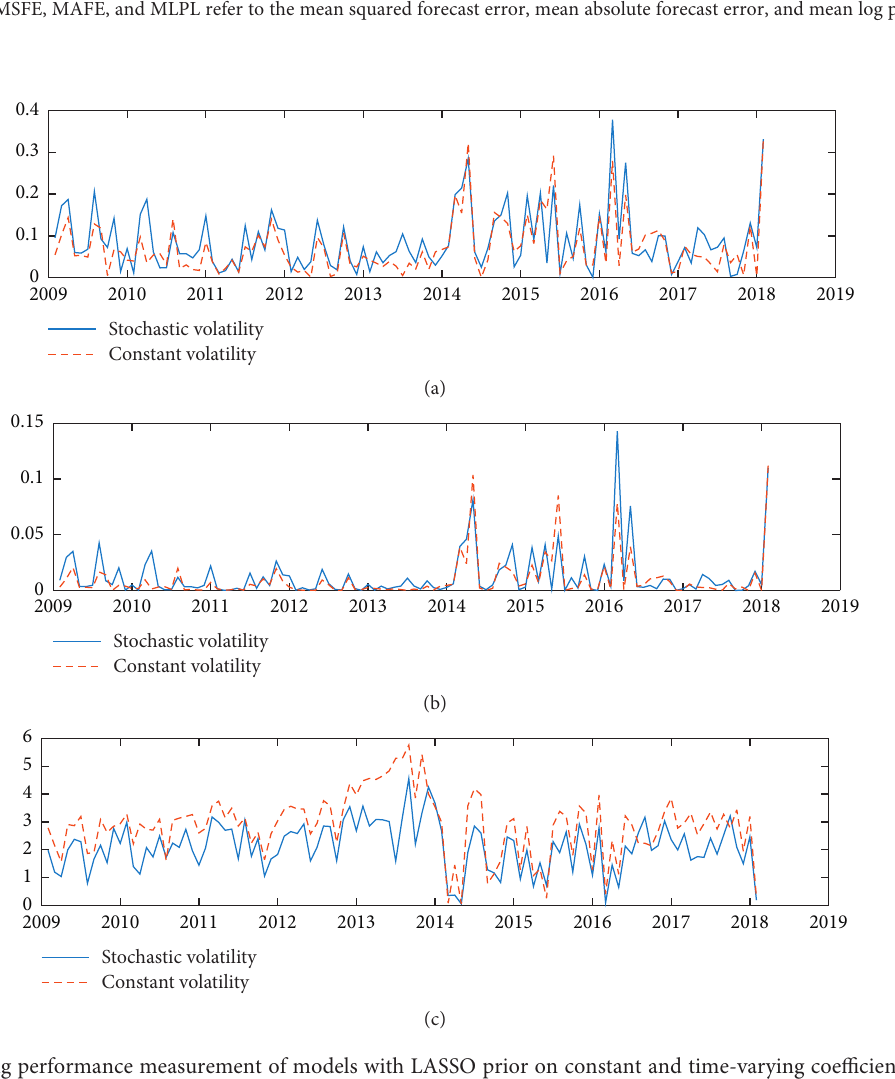
LASSO only on constant